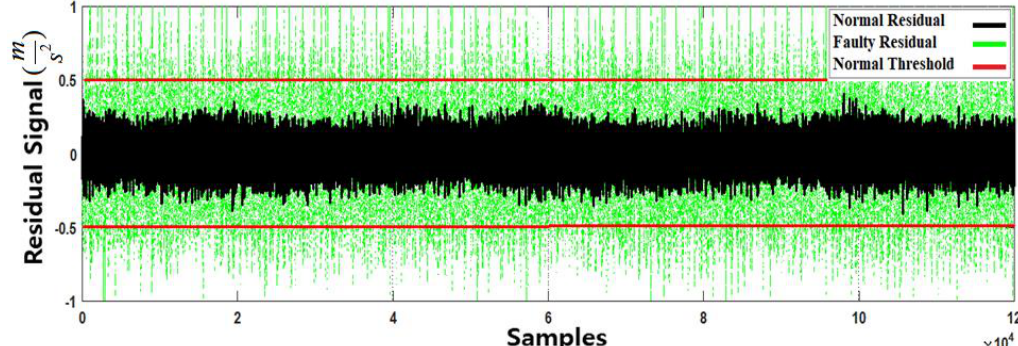
Figure 11. Residual signal for the normal condition, faulty condition, and the normal threshold value for fault detection.